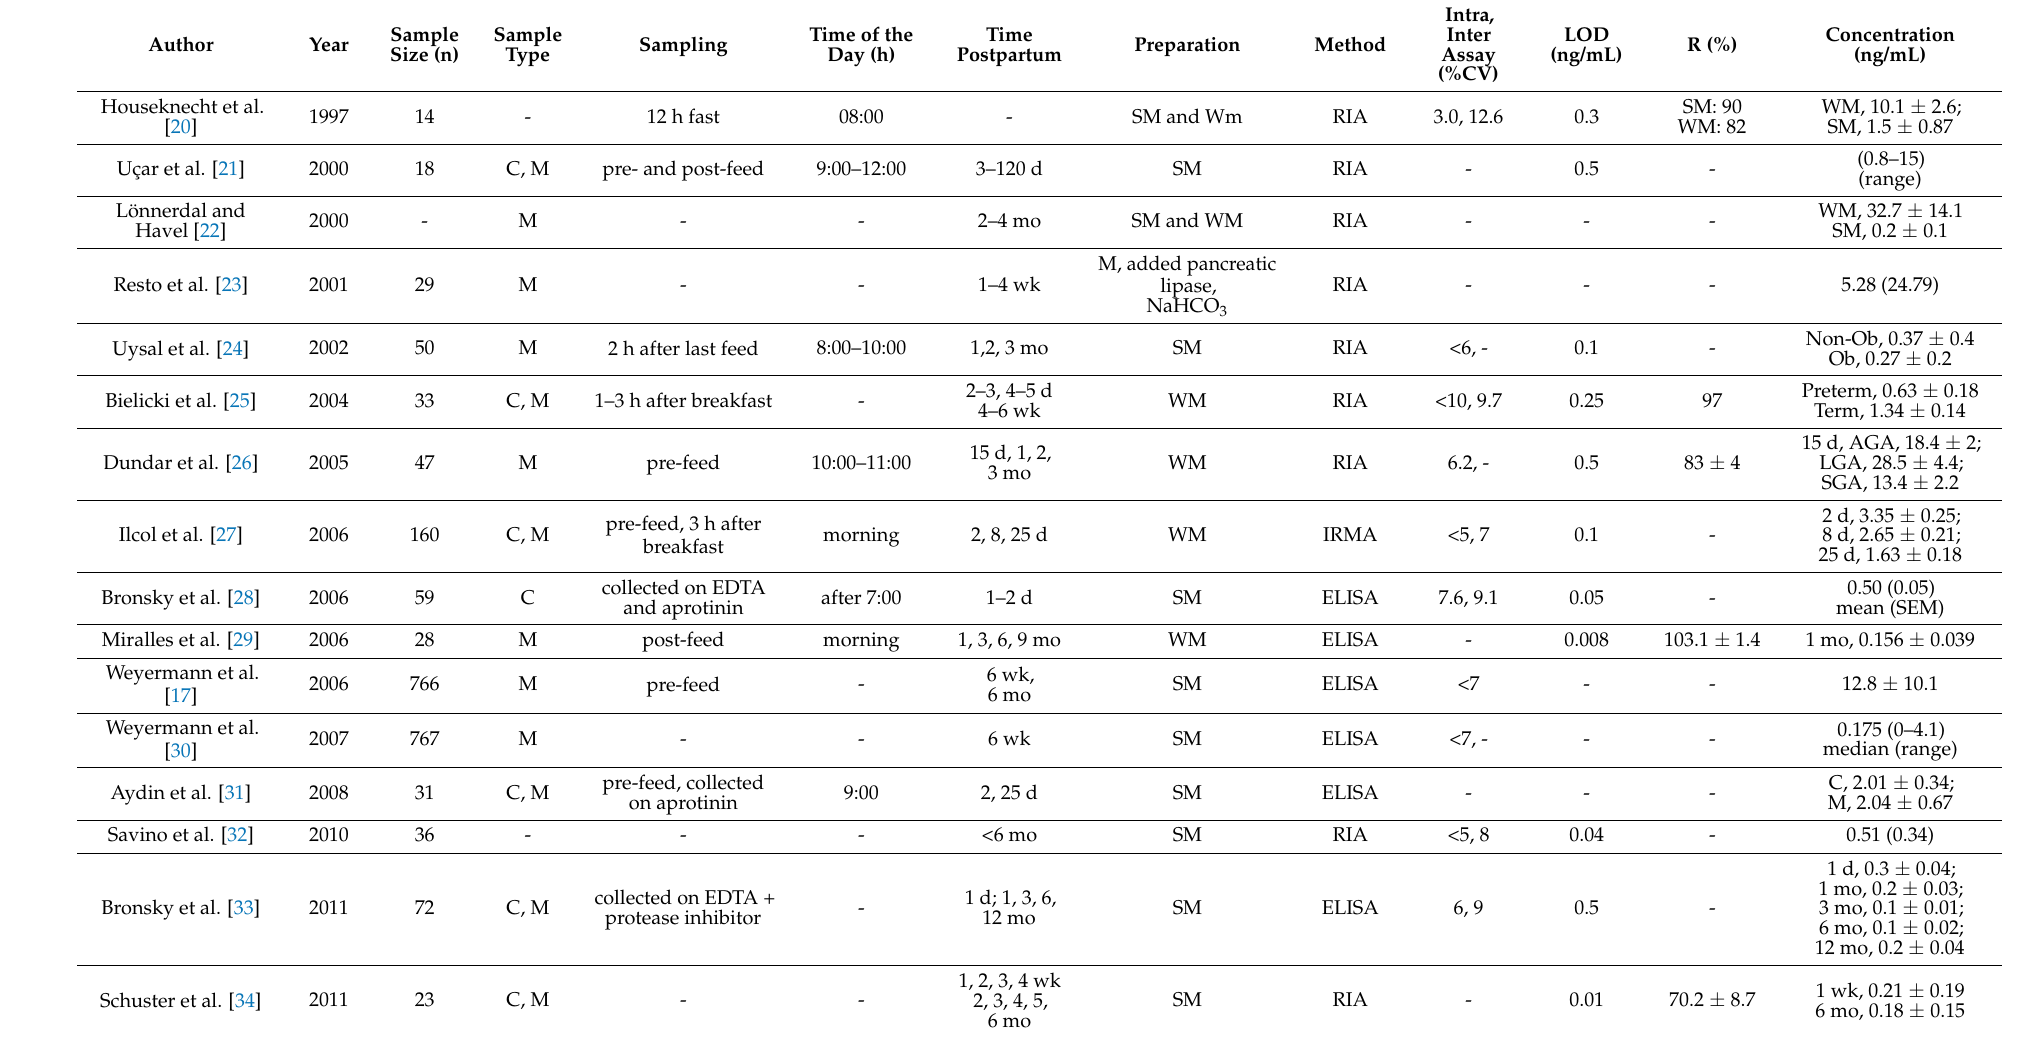
Table 1. Studies examining human milk